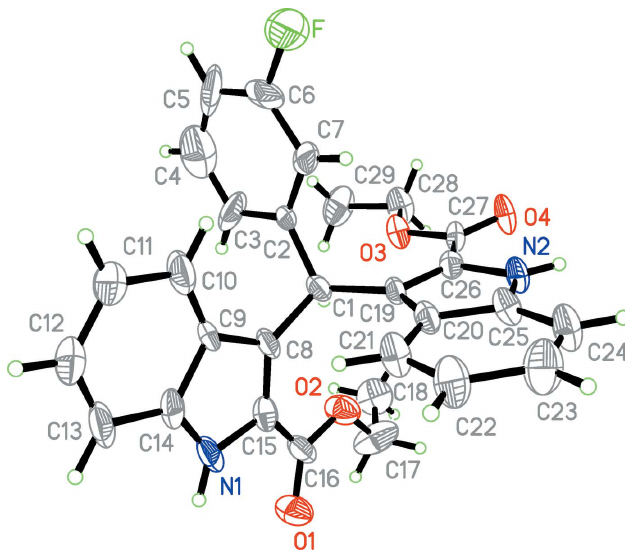
Figure 1 The molecular structure of the title molecule with displacement ellipsoids drawn at the 30% probability